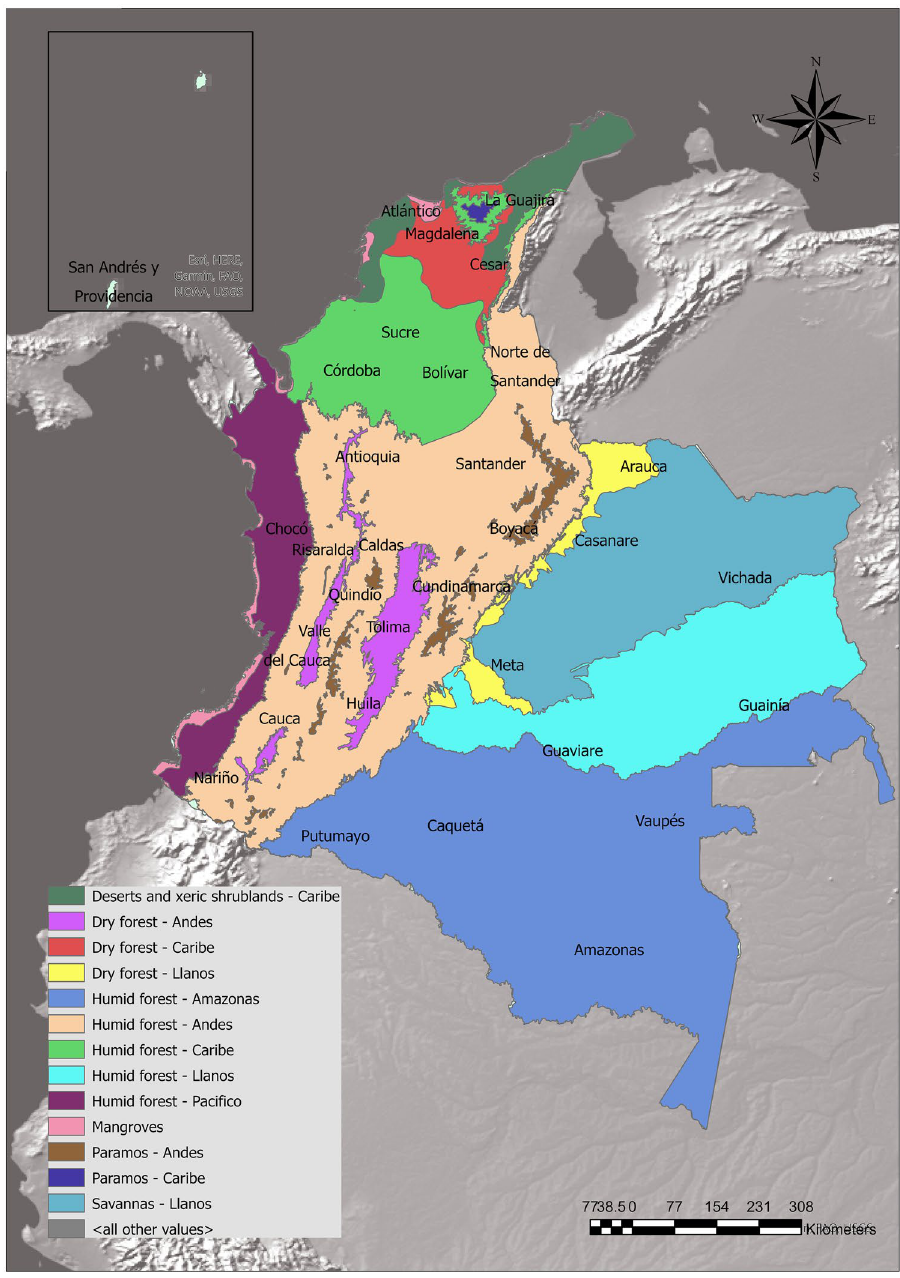
Figure 1. Overview of Colombian bioregions, generated in ArcGIS Pro 2.9.0. https:// www. arcgis. com/ index.